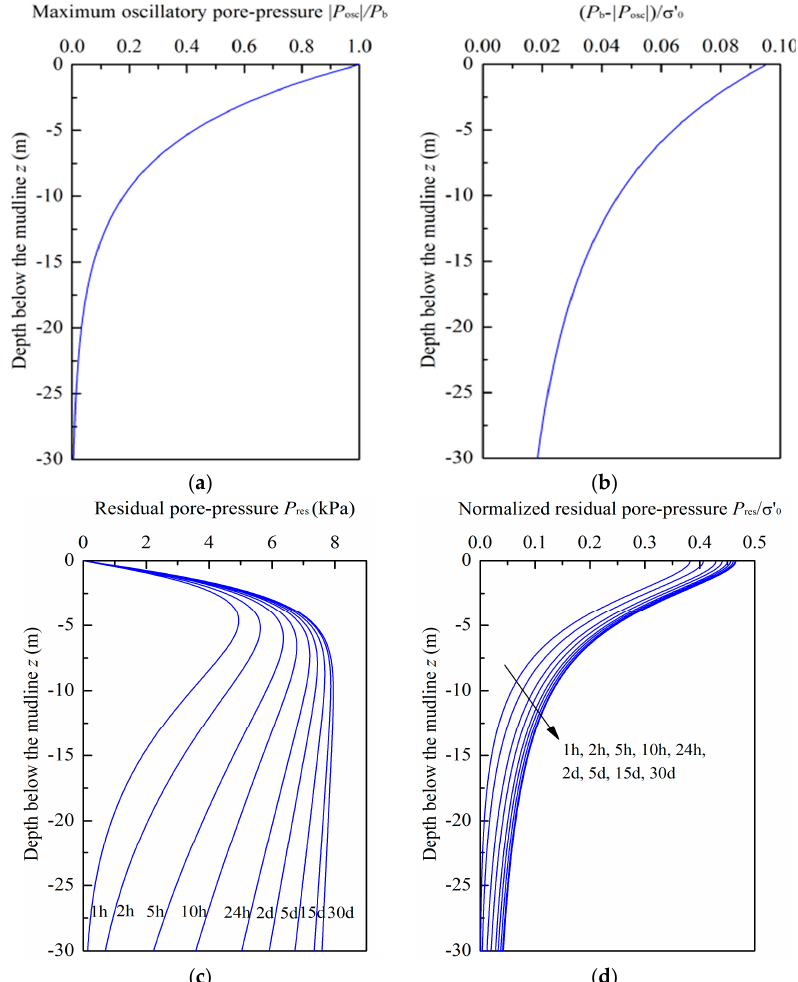
Figure 5. Distributions of the oscillatory pore-pressure and the residual pore-pressure: ( a ) Vertical distribution of | P osc | / P b ; ( b ) vertical distribution of ( P b − | P osc | ) / σ (cid:48) different times; ( d ) vertical distribution of P res / σ (cid:48) for different times;